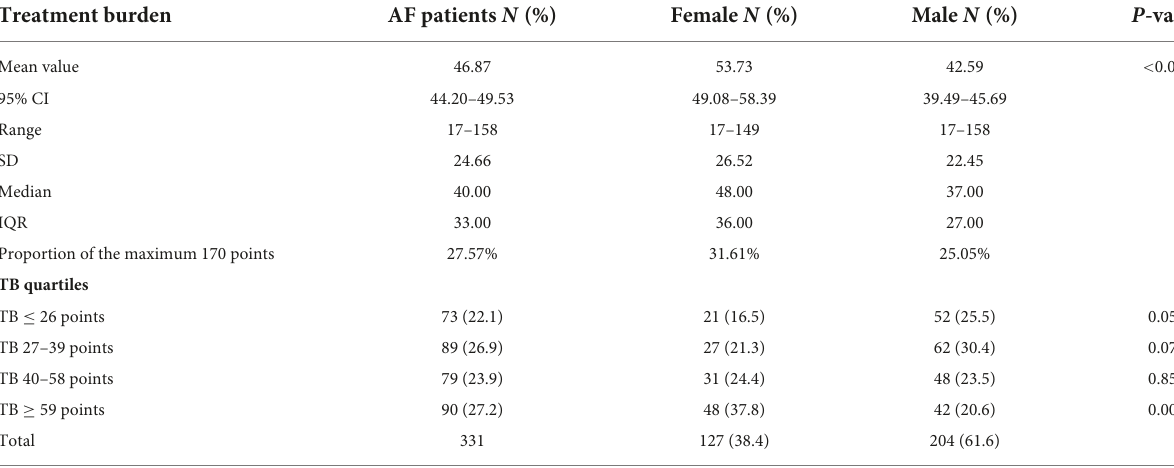
TABLE 2 The distribution of study cohort per quartiles of treatment burden in atrial fibrillation (AF). Treatment burden AF patients N (%)